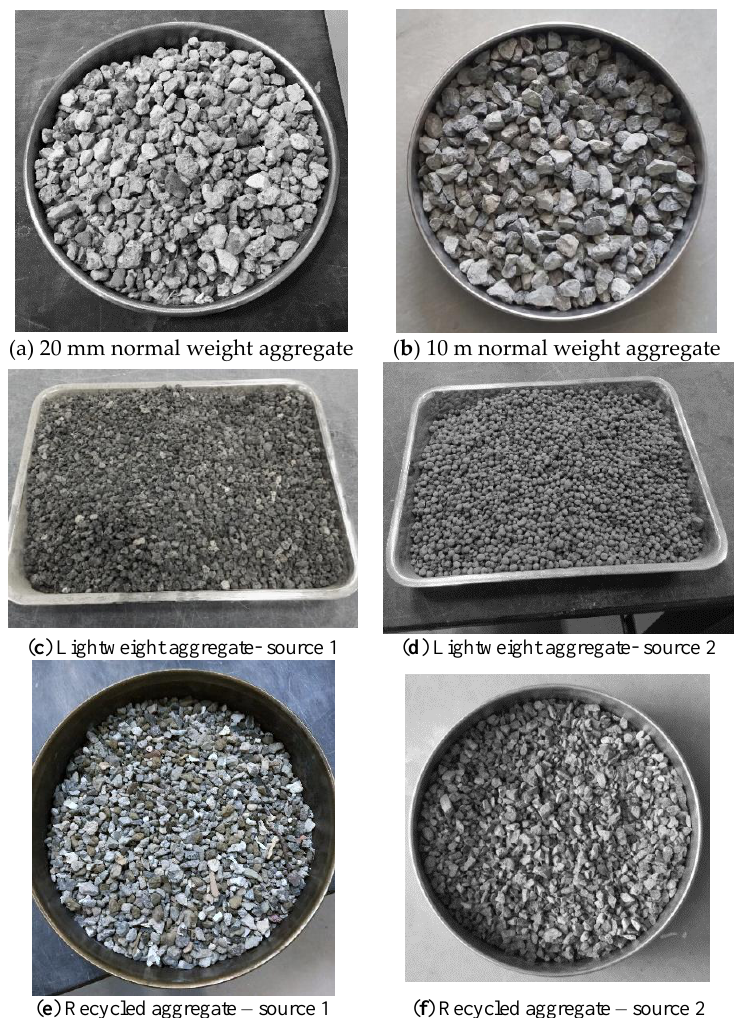
Figure 2. Coarse aggregate used in the investigation. Table 4. Summary of the coarse aggregate properties.